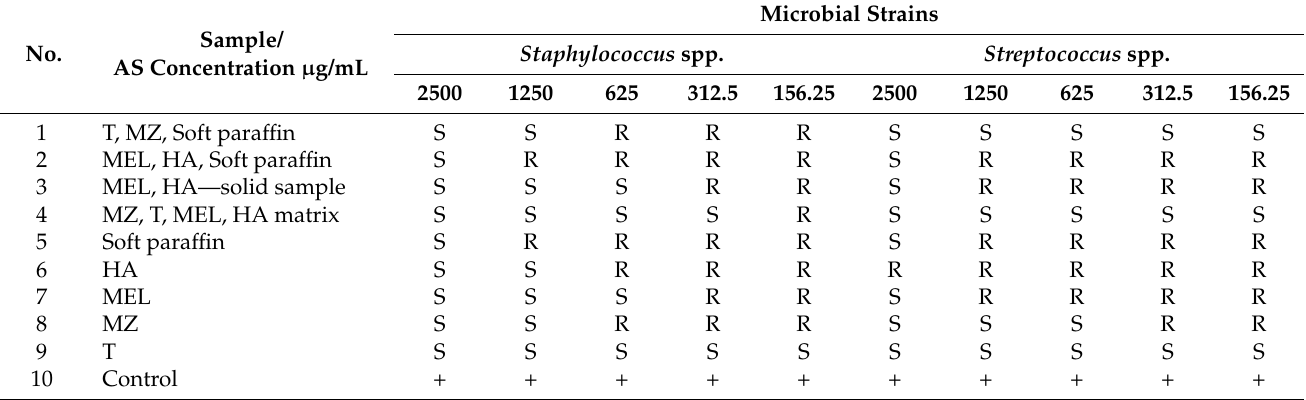
Table 2. Antimicrobial activity of HA, MEL, MZ, T, soft paraffin, and mixtures against Staphylococcus spp. and Streptococcus